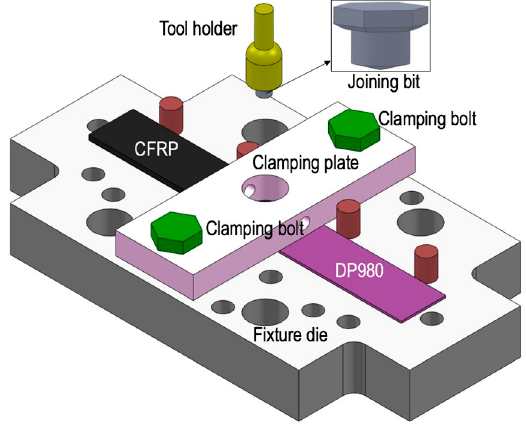
Figure 2. Schematic view of the lap shear joint-configured sample holder and the clamped parts used in this study.